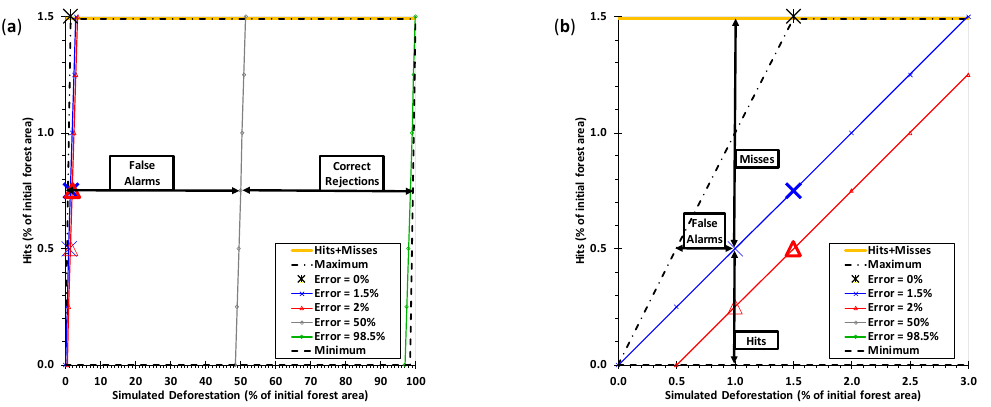
Figure 4. Lines for constant total error in TOC space at ( a ) full range and ( b ) zoomed in.